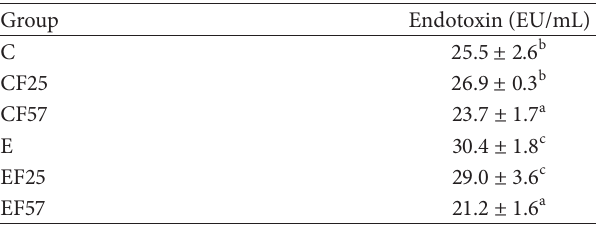
Table 7: Effects of fish oil on endotoxin concentrations in rats under chronic ethanol feeding 1,2 .